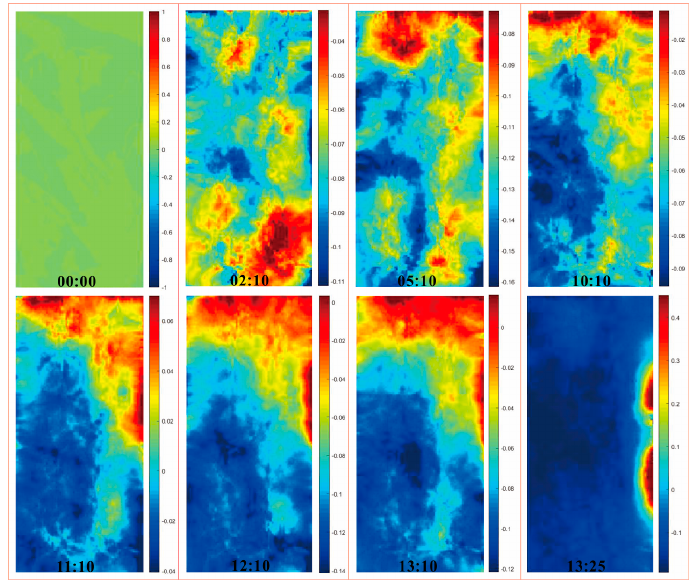
Figure 14. Nephogram maps of axial displacement of C8.